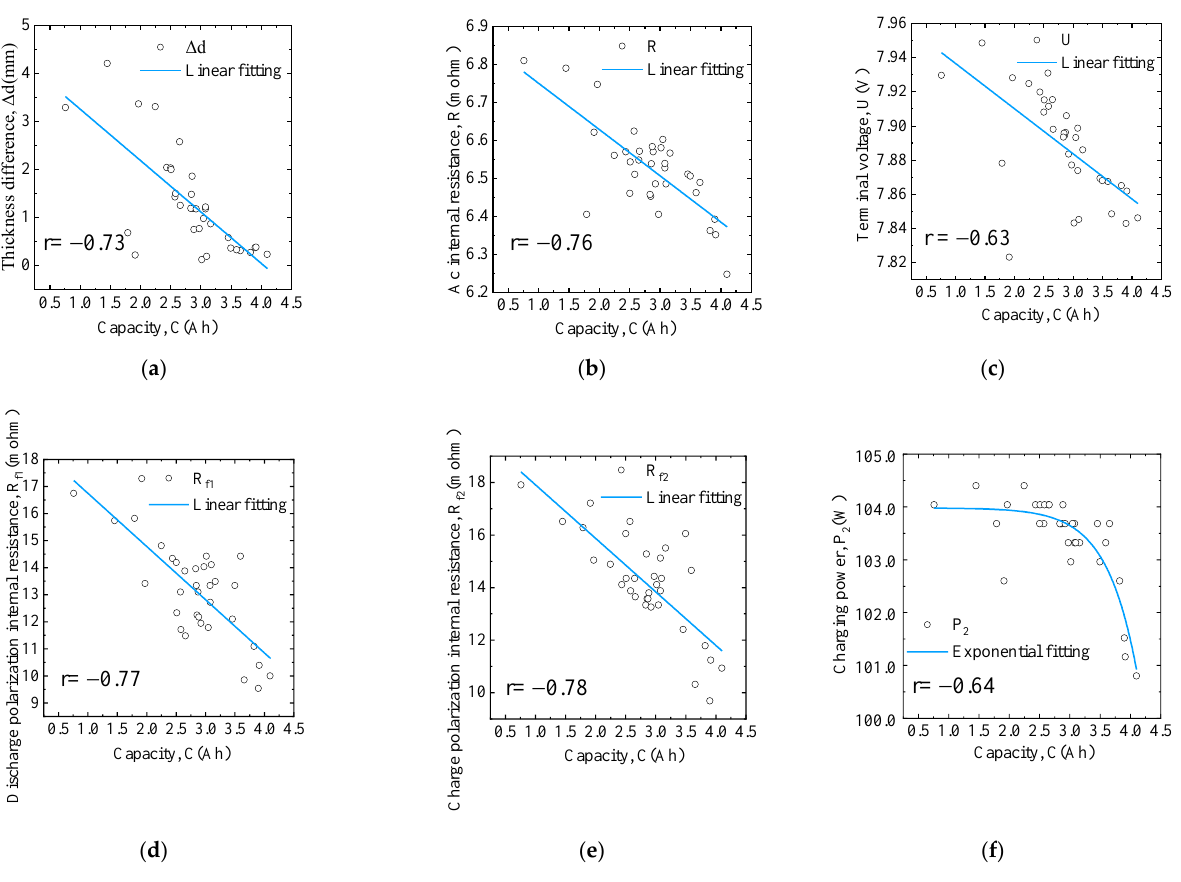
Figure 5. The distribution of parameters with discharge capacity for r ≥ 0 .6 or r ≤ − 0.6. ( a ) Difference in volume expansion thickness; ( b ) AC internal resistance; ( c ) terminal voltage; ( d ) discharge polarization internal resistance; ( e ) charge polarization internal resistance; ( f ) charging power.